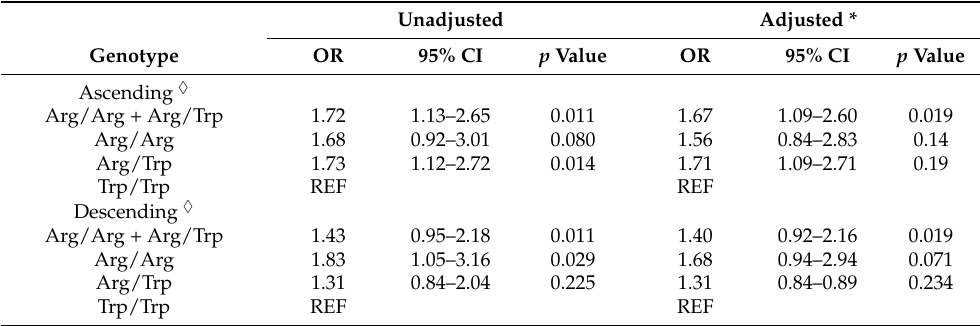
Table A4. Association of KIF6 719Arg with ascending and descending thoracic aortic dissection (All; typical, intramural hematoma, and penetrating atherosclerotic ulcer cases).